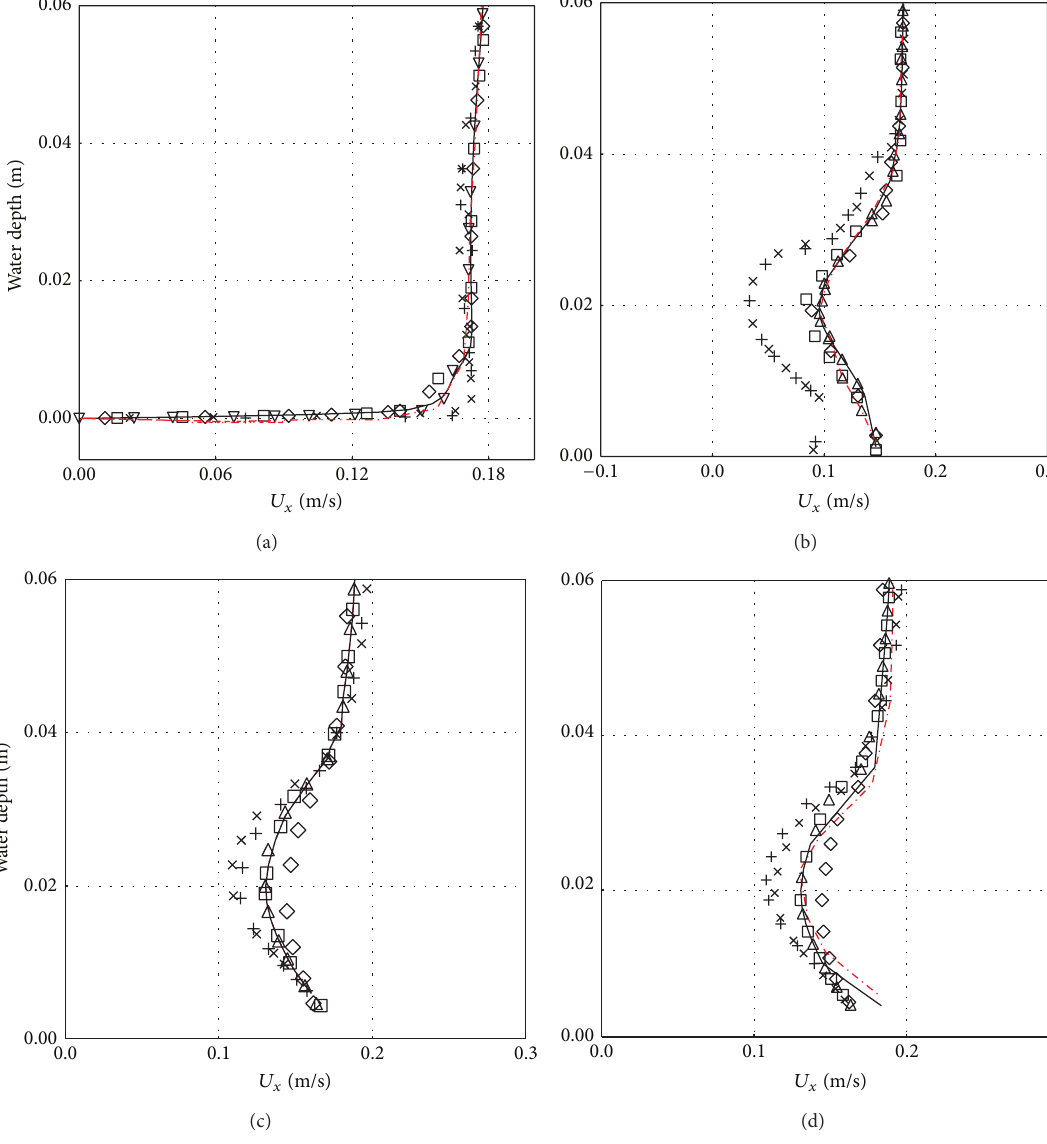
Figure 5: Unsteady horizontal velocity ( 𝑈 𝑥 ) at different positions, (a) 𝑋/𝐷 = −3.0 , (b) 𝑋/𝐷 = 1.0 , (c) 𝑋/𝐷 = 1.5 , and (d) 𝑋/𝐷 = 2.0 with different turbulent models — standard 𝑘 - 𝜀 , ⬦ RNG 𝑘 - 𝜀 , △ realizable 𝑘 - 𝜀 , × standard 𝑘 - 𝜔 , + SST 𝑘 - 𝜔 , and ◻ Reynolds stress model (RSM) Red